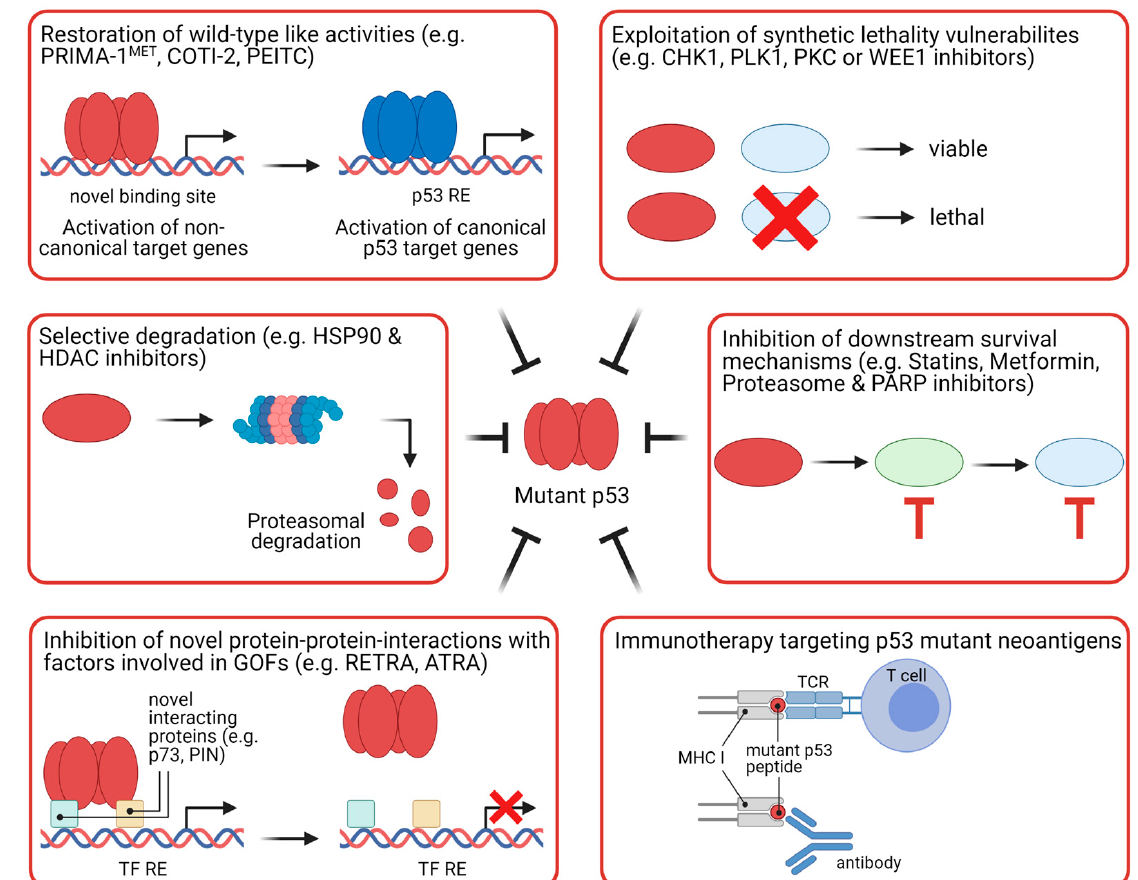
Figure 8. Therapeutic strategies of targeting mutant p53. Approaches targeting p53 mutant that are new or are already in clinical trials can be classified into six categories: restoration of wild-type like activities to mutant p53; selective degradation of mutant p53; inhibition of novel protein–protein interactions involved in mediating gain-of-functions of mutant p53; exploitation of synthetic lethality vulnerabilities of mutant p53; inhibition of downstream survival pathways augmented by mutant p53; and immunotherapy based on the recognition of mutant p53 neoantigens. GOF, gain-of-function; MHC I, major histocompatibility complex class I; RE, response element; TCR, T-cell receptor; TF, transcription